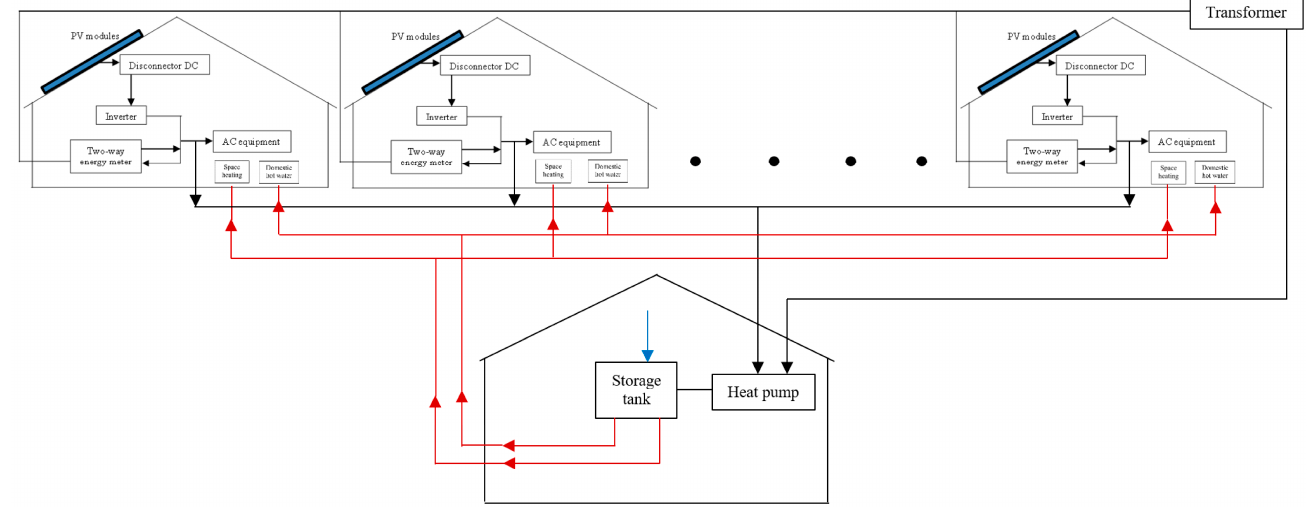
Figure 8. Schematic diagram of a modern energy system with common local district heating system based on a central heat pump (or heat pumps) powered by electricity generated by local photovoltaic systems in micro housing estate.